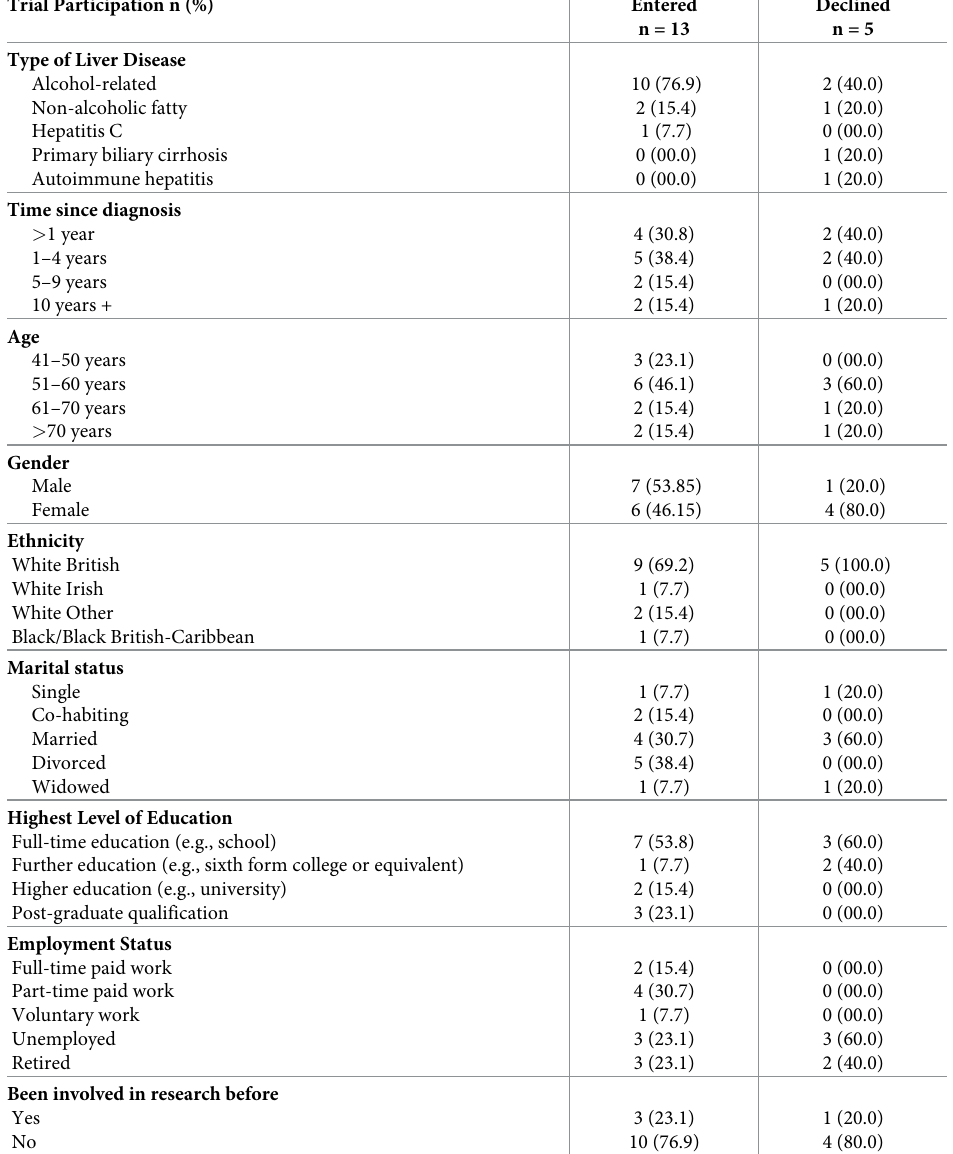
Table 2. Patient participant